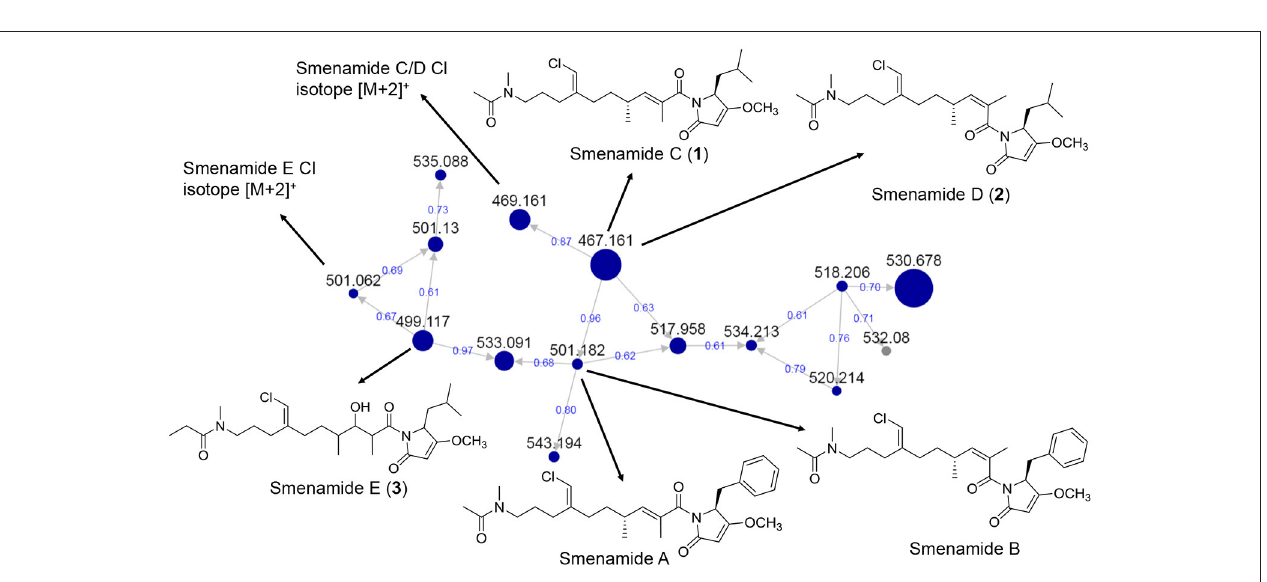
(H 3 -25, δ H 1.97) showed an HMBC correlation to C-24 and characterized the western half of 1 with an N -methyl acetamide functionality. In the second partial structure of 1 (b), another moderately deshielded diastereotopic methylene group (H-17a, δ δ H 2.22; H-17b, H 2.10) showed COSY correlations to the H-16 methylene (H-16a, δ H 1.49; H-16b, δ H 1.35). H 2 -16 showed